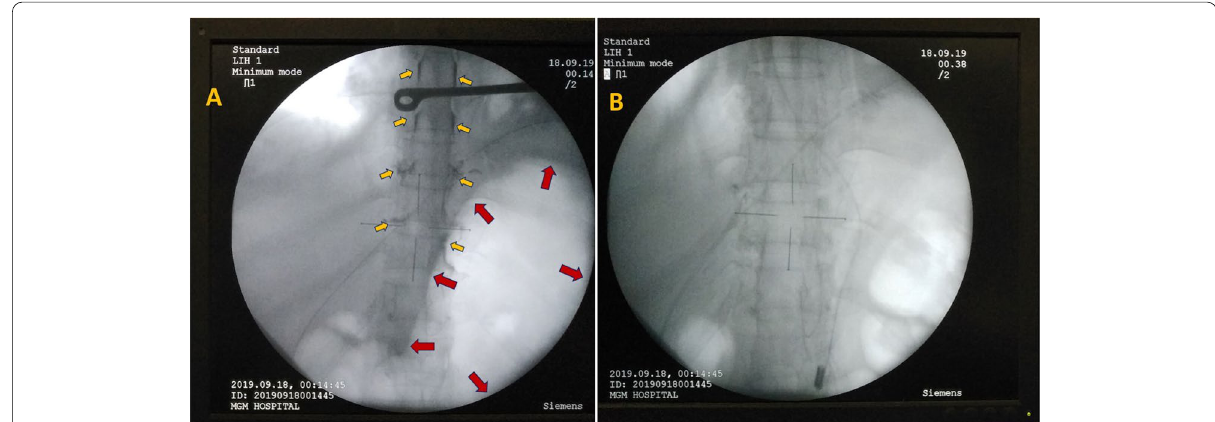
Fig. 1 A The yellow arrows indicate tram-track spread of contrast with spillage through the intervertebral foramen confirming epidural placement of the catheter. The red arrows indicate the massively distended stomach. In panel B , the stomach is seen deflated after insertion of the nasogastric